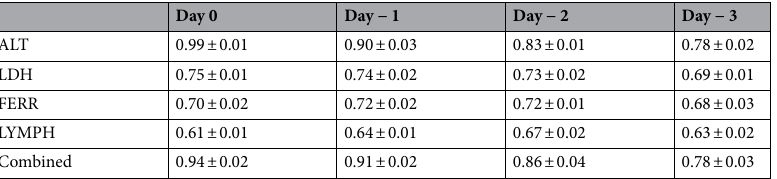
Table 2. Performance metrics (AUCs) of the individual top predictors of severe liver injury onset. For combined models using all top variables shown, AST was excluded due to its strong correlation with ALT.